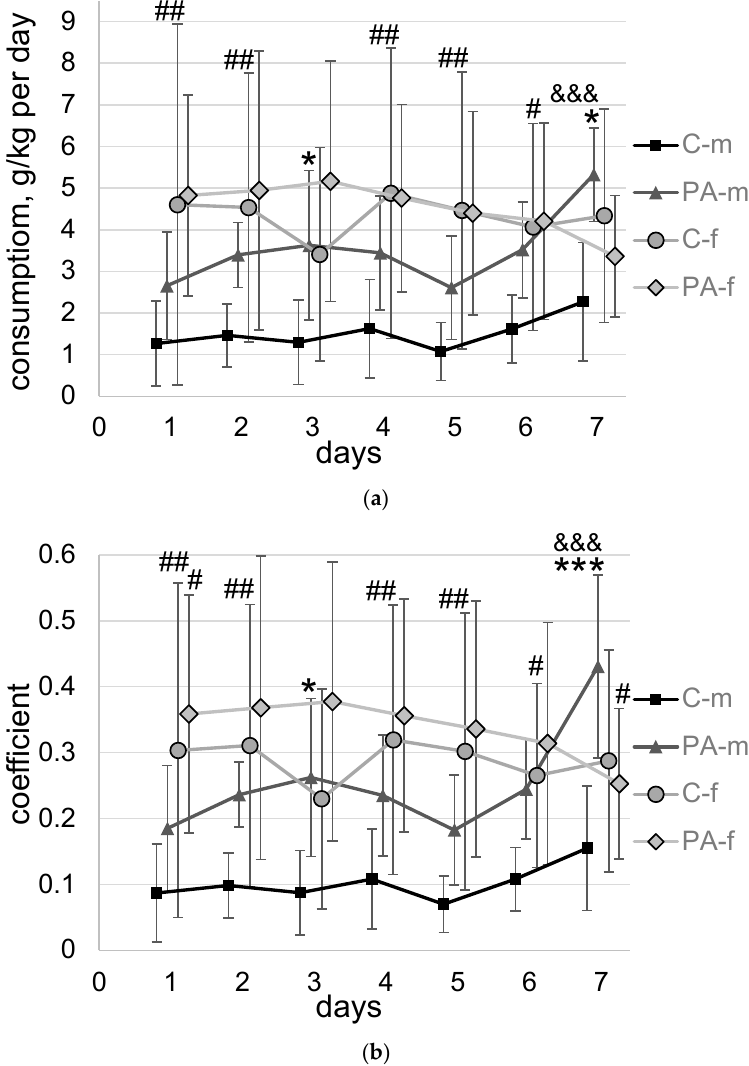
Figure 2. Two-bottle-choice paradigm. Data present as mean ± SD. ( a )—alcohol consumption, g/kg of absolute ethanol per day; ( b )—alcohol preference, coefficient: the ratio of alcohol consumed volume to total volume of alcohol and water consumed. C-m—male naïve rats, n = 11; PA-m—male PAE rats, n = 10; C-f—female naïve rats, n = 8; PA-f—female PAE rats, n = 10. Rats were provided with 24 h/day access to two-bottle choice drinking (one bottle contained 10% alcohol, the other contained water) for 7 days. Asterisk (*) indicates a significant difference between naïve and PAE rats of the same sex: *— p < 0.05, ***— p < 0.001; post hoc Duncan’s test. Hash (#) indicates a significant difference between groups of the same name of different sex: #— p < 0.05; ##— p < 0.01; post hoc Duncan’s test. Ampersand (&) indicates a significant difference between Day 1 and Day 7 inside a group: &&&— p < 0.001; post hoc Duncan’s